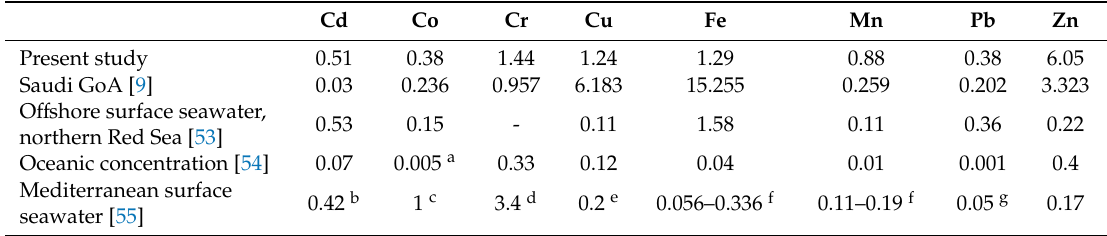
Table 4. Comparison of selected metals ( µ g / L) in surface seawater of GoA relative to other regions. Cd Co Cr Cu Fe Mn Pb Zn Present study 0.51 0.38 1.44 1.24 1.29 0.88 0.38